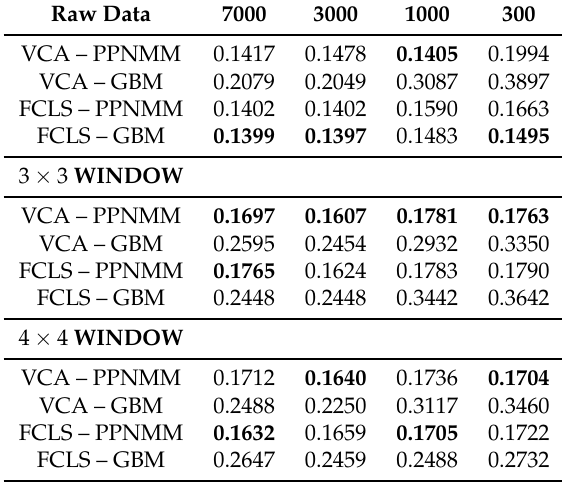
Figure 7. Abundance estimate of endmembers of the Samson data showing the groundtruth, linear (VCA), nonlinear (PPMM) and the hybrid methods. From top water ; rock ; tree . Table 4. Average abundance estimation error of the hybrid methods with different numbers of training samples (7000 to 300) and different window size vectors on the Jasper Ridge data as compared with the abundance estimation error of the individual methods which are: PPNMM = 0.2115, GBM = 0.2441, VCA = 0.6513, and FCLS = 0.1832. The best results are shown in bold. Raw Data 7000